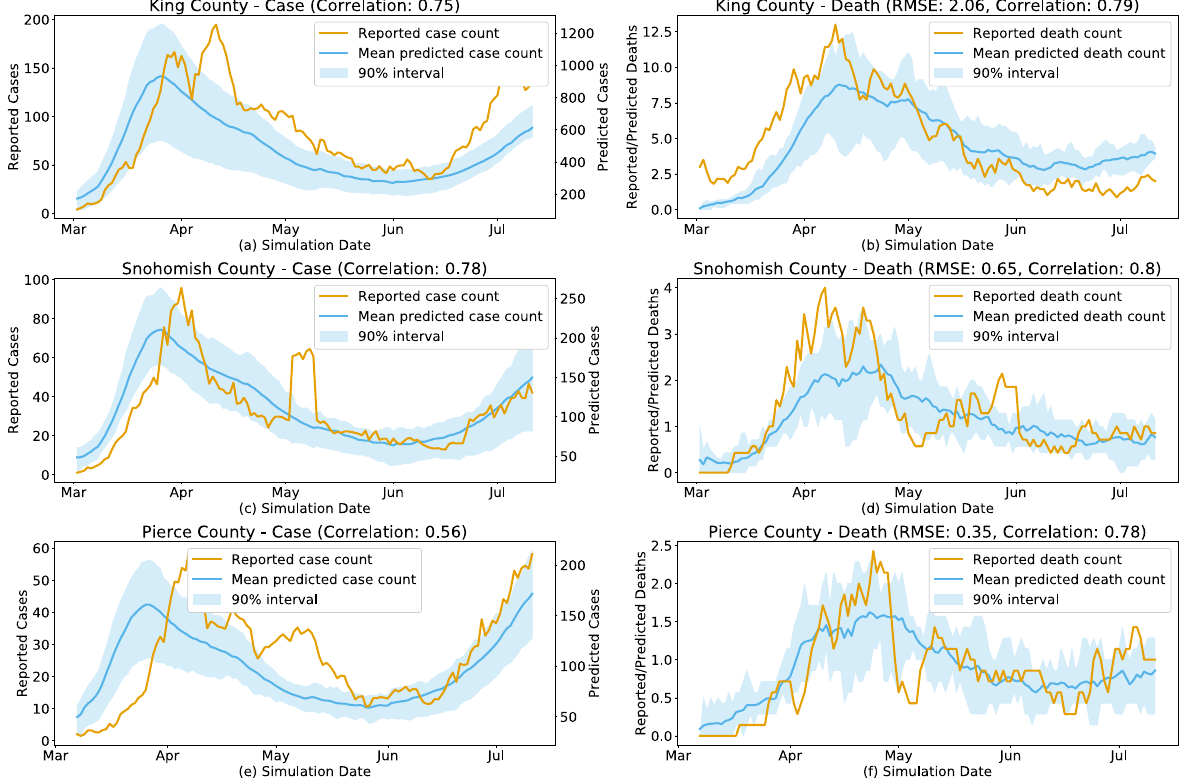
Fig. 9 Calibrated simulation vs observed epidemic dynamics. Daily reported and predicted COVID-19 deaths in King County, WA (Correlation: 0.75) ( a ), Pierce County, WA (Correlation: 0.78) ( c ), and Snohomish County, WA (Correlation: 0.56) ( e ) and daily reported and predicted COVID-19 cases for King County, WA (RMSE: 2.06, Correlation: 0.79) ( b ), Pierce County, WA (RMSE: 0.65, Correlation: 0.80) ( d ), and Snohomish County, WA (RMSE: 0.35, Correlation: 0.78) ( f